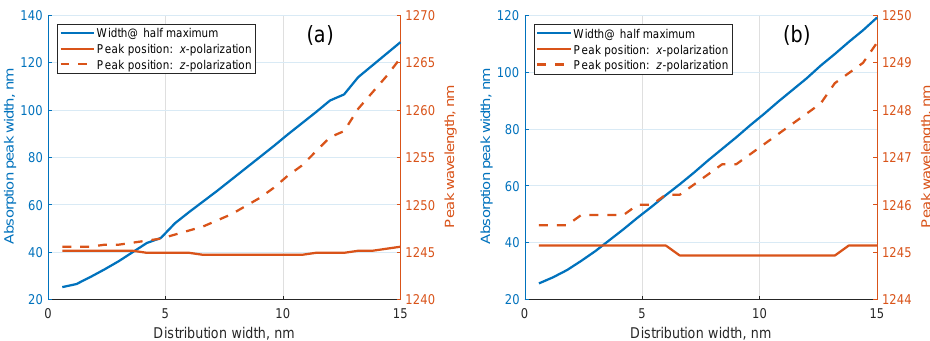
Figure 2. Dependence of the width at half maximum and the positions of the longitudinal plasmon absorption peak for x - and z -polarizations on the width of the particle size distribution for rectangular ( a ) and Gaussian ( b )